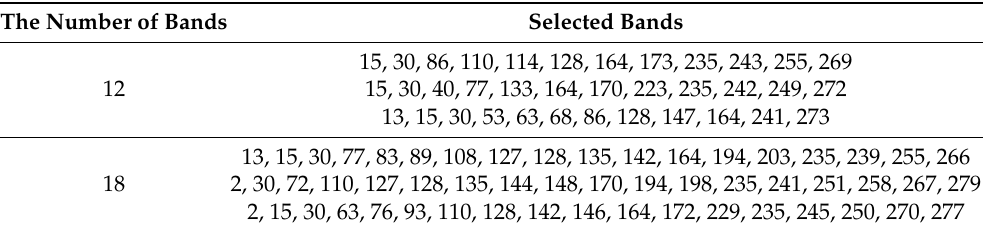
Table 9. Selected bands by the proposed method on mulberry fruit dataset. The Number of Bands Selected